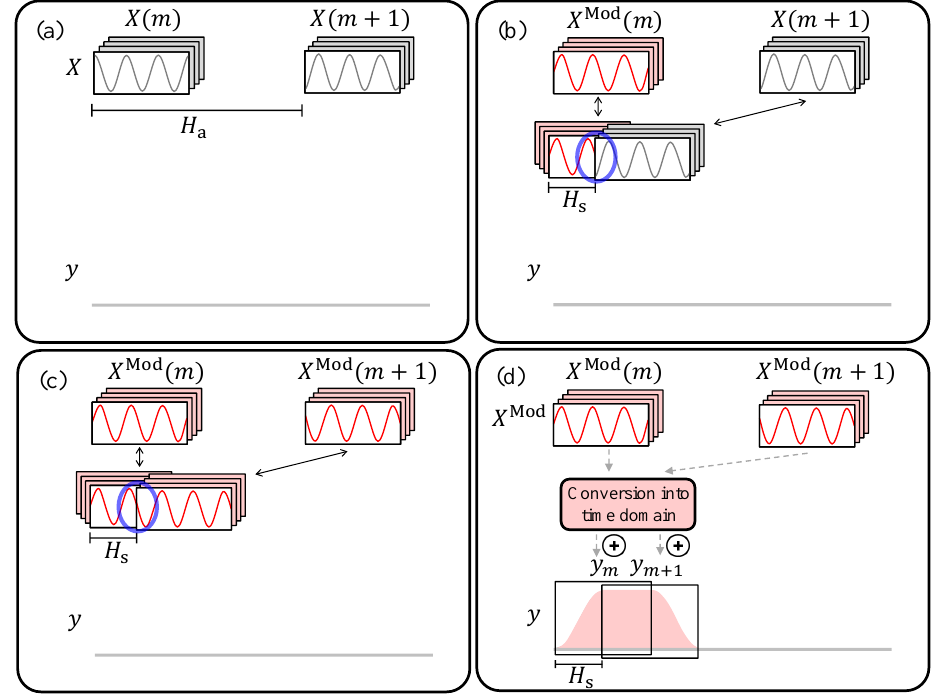
Figure 9. The principle of TSM Based on the Phase Vocoder (PV-TSM). ( a ) STFT X (time-frequency bins are visualized by sinusoidals); ( b ) Using the original phase of X ( m + 1, k ) leads to phase jumps when overlapping the frames at the synthesis hopsize H s (blue oval); ( c ) Update of the sinusoids’ phases via phase propagation. Phase jumps are reduced (blue oval); ( d ) Signal reconstruction from the modified STFT X Mod